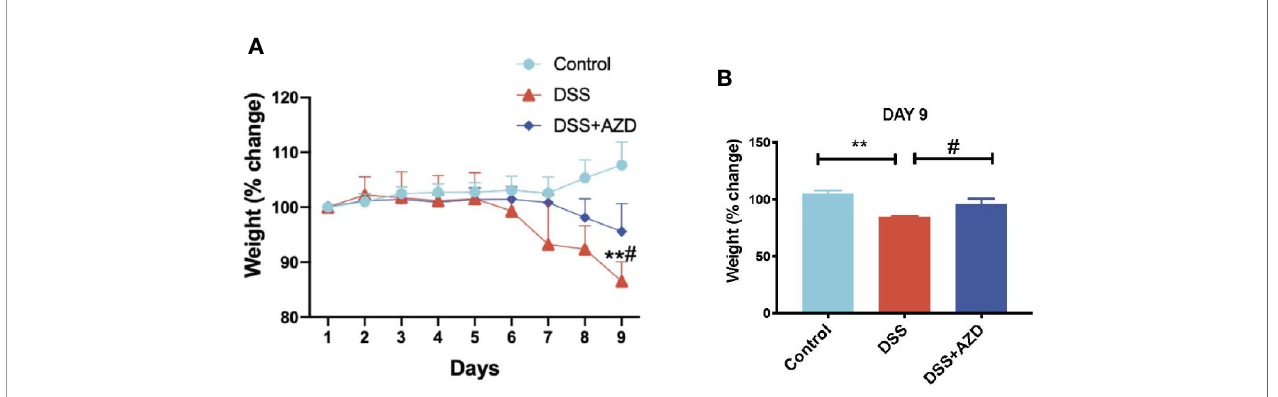
FIGURE 2 | Orally available AZD3241 attenuates body weight loss in mice challenged with dextran sodium sulfate (DSS). Mice were randomly divided into three treatment arms over 9 days i) vehicle group (n=5) given normal drinking water and peanut butter without drug; ii) DSS group (n=5) given 2% w/v DSS in drinking water and peanut butter without drug; iii) DSS+AZD3241 (n=5) given 2% w/v DSS in drinking water and AZD3241 @ 30 mg/kg in peanut butter. (A) Percent body weight loss in mice over 9 days. (B) Percent body weight loss at day 9 of experiments. **Different to the control, ( p < 0.001). # Different to the DSS+AZD3241 group, (p = 0.01). AZD3241 is abbreviated to AZD in this fi gure.